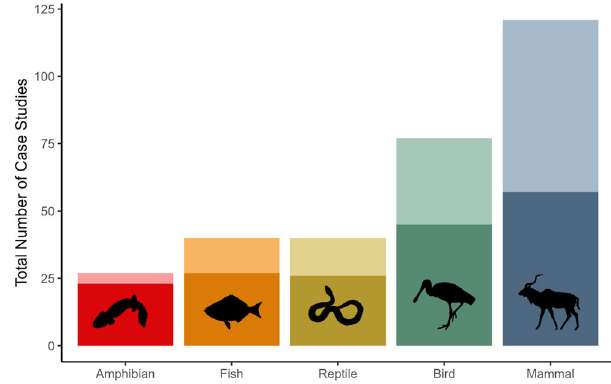
Fig. 1 | Inclusion of human dimension objectives in wildlife translocations varied among taxa. Data is based on case studies from the IUCN Global Re- introduction Perspectives Series (2008 – 2021). Lighter shading indicates the num- ber of case studies that included human dimension objectives; darker shading representscasestudiesthatdidnotincludehumandimensionobjectives.Bytaxon, the percent of translocations that did not include human dimension objectives were: Amphibians: 85%; Fish: 68%; Reptiles: 65%; Birds: 58%; Mammals: